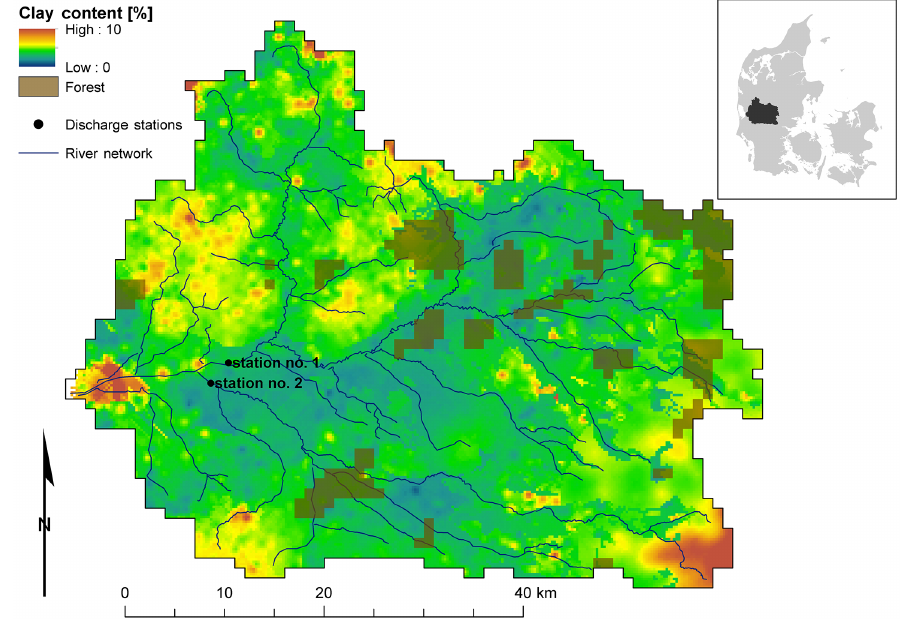
Figure 1. Skjern River catchment in western Denmark. The map shows the spatial distribution of soil properties, forest areas and the river network. Additionally, two discharge stations used in the optimizations are